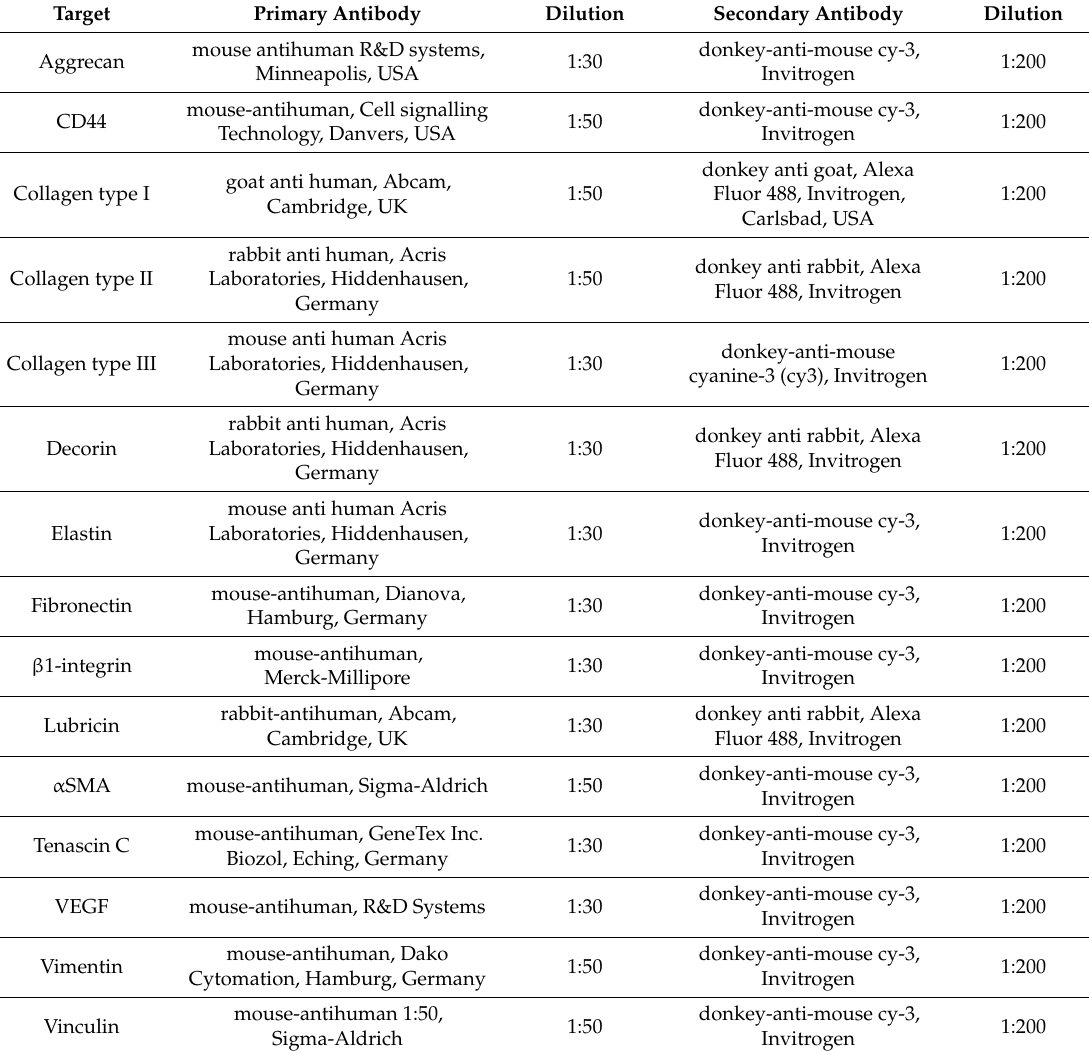
Table 1. The antibodies used.